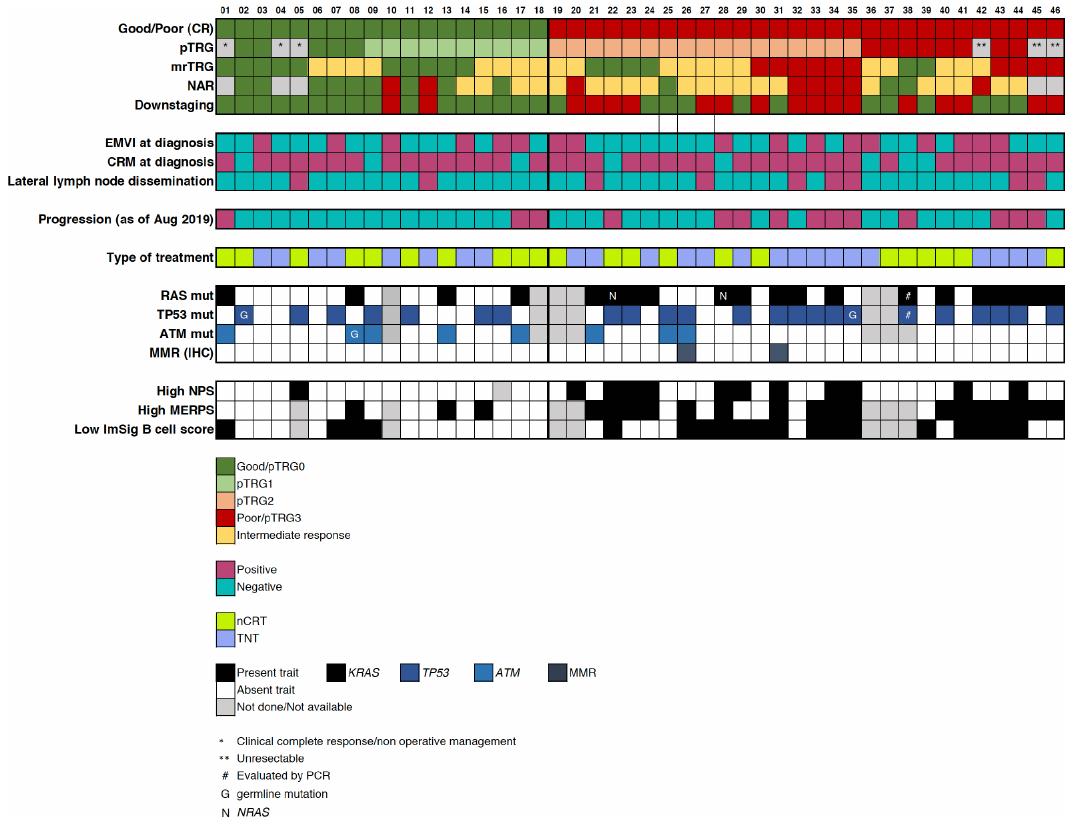
Figure A1. By-subject selected clinical and molecular characteristics of good and poor nCRT responders. Columns represent patients with response data and any molecular data available ( n = 46), while rows display clinical and molecular variables that measure response to nCRT and association (or not) with that response. See Table 2 for statistical analysis. Patients in whom response could not be evaluated were not included even if they have molecular or clinical data used for other analysis. CR = Consensus Response; pTRG = pathologically assessed Tumor Regression Grade; mrTRG = MRI-assessed Tumor Regression Grade; NAR = Neoadjuvant Rectal Score; EMVI = Extramural Vascular Invasion; CRM = Circumferential Radial Margin; MMR = Mismatch Repair; IHC = Immunohistochemistry; NPS = Neutrophil Platelet Score; MERPS = Median Repair Pathway Score; nCRT = Neoadjuvant Chemoradiotherapy; TNT = Total Neoadjuvant